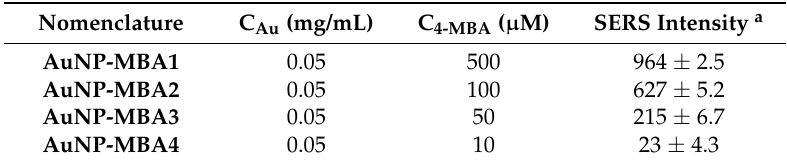
Table 1. The conditions and results for the preparation of the AuNP-MBA. Table1. The conditions and results for the preparation of the AuNP-MBA.